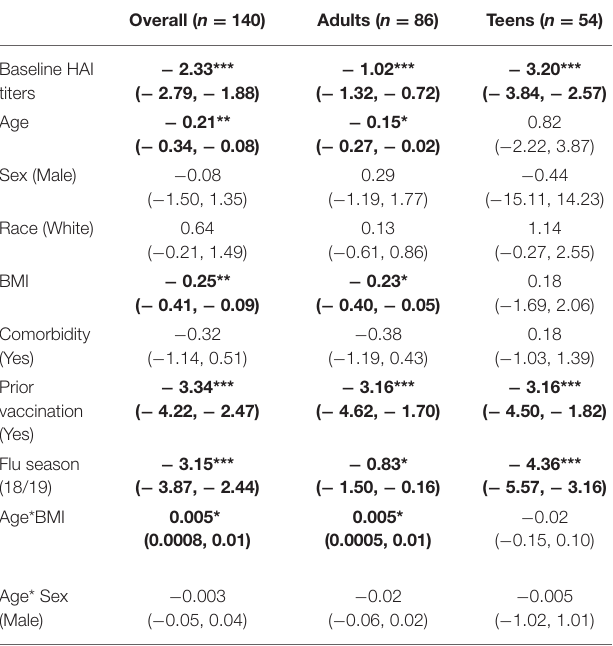
TABLE 2 | Coefficient estimates of host variables fitted in linear model with